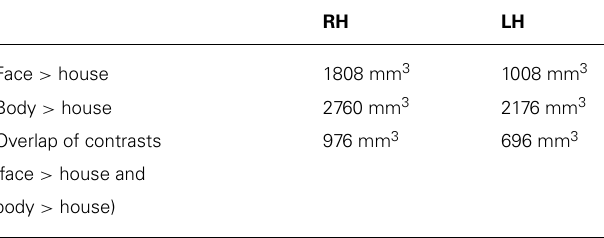
Table 2 | Overall volume of activated voxels from group-level